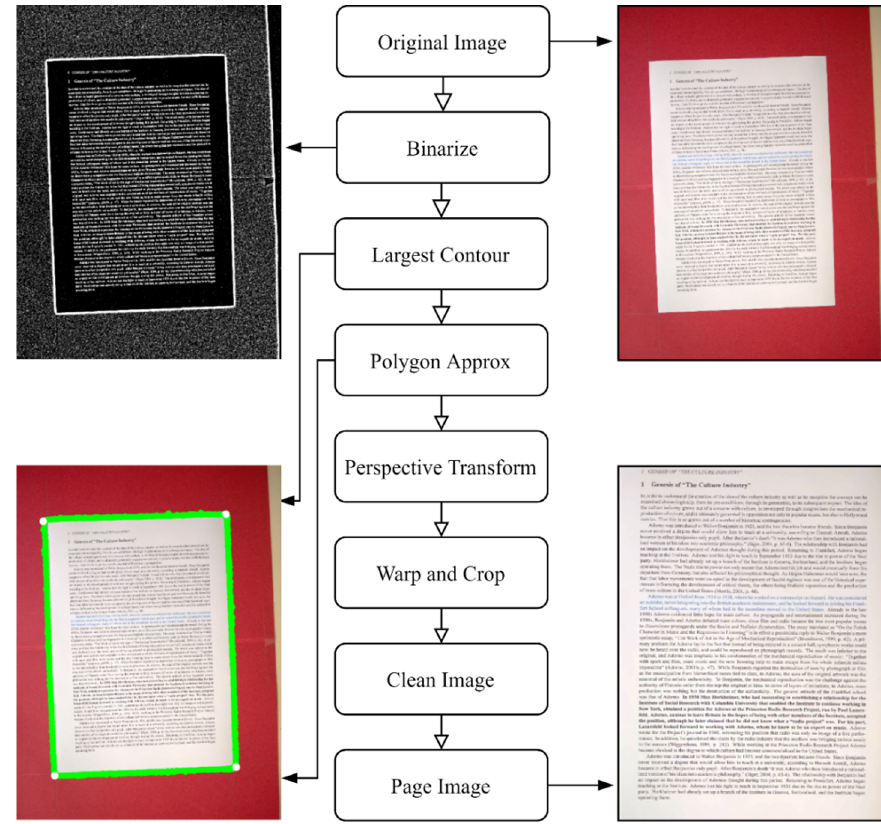
Figure 4. The workflow for the Page Extractor.